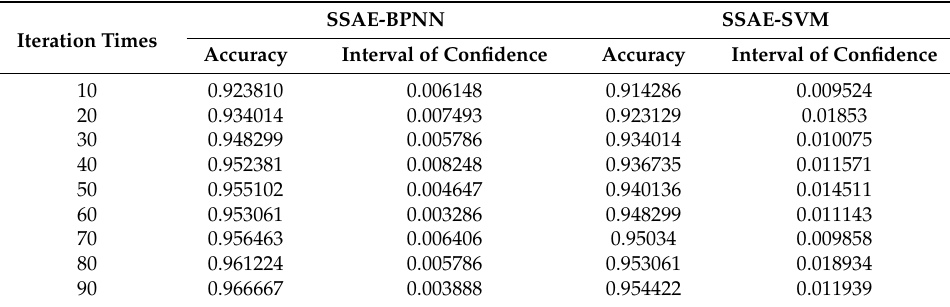
Figure 14. Comparison of SSAE-BPNN and SSAE-SVM. Table 4. Accuracy and interval of confidence of SSAE-BPNN & SSAE-SVM.